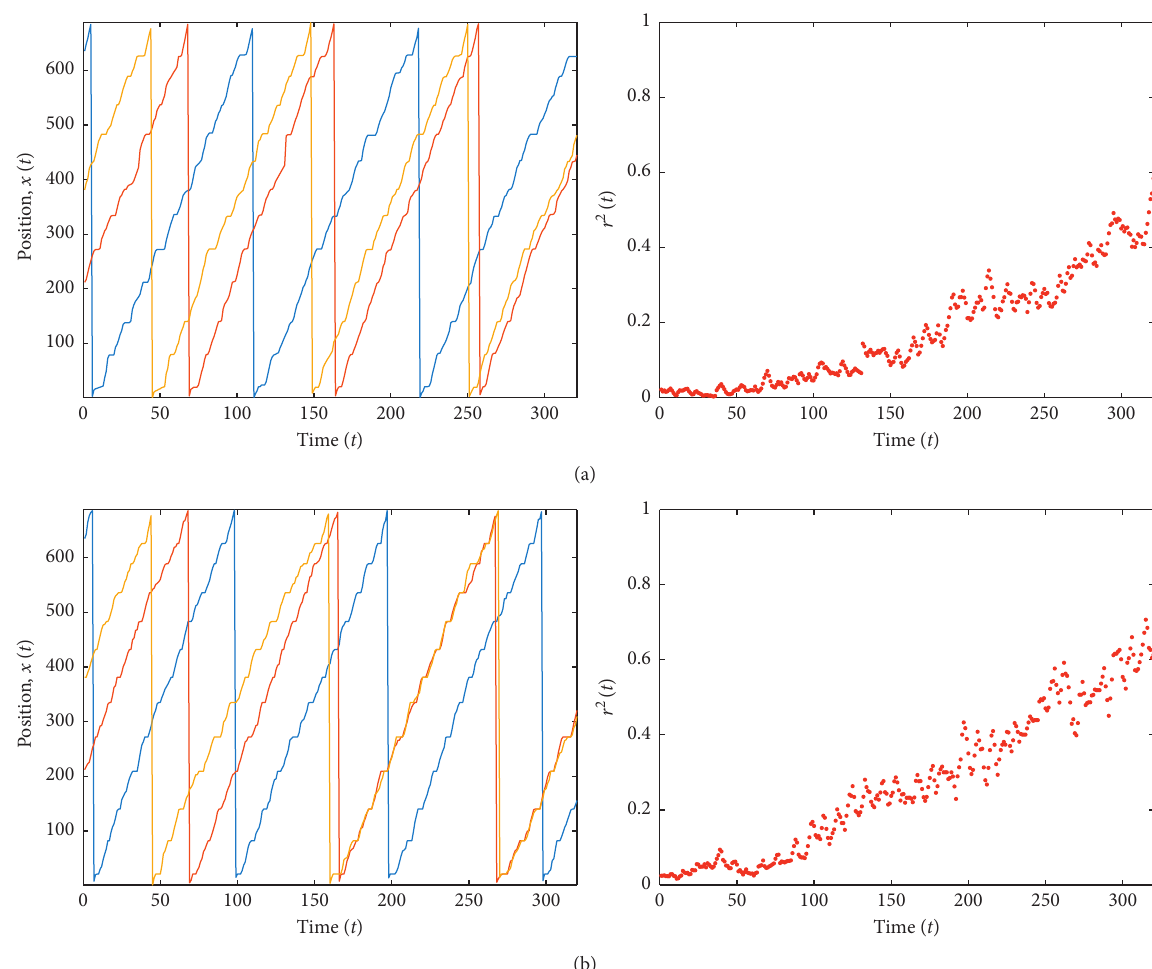
Figure 3: Empirical trajectories of the three buses operating on 11 September 2018, from 1404h to 1516h. The r 2 time series is derived from the trajectories and equation (2). (a) Empirical. (b)